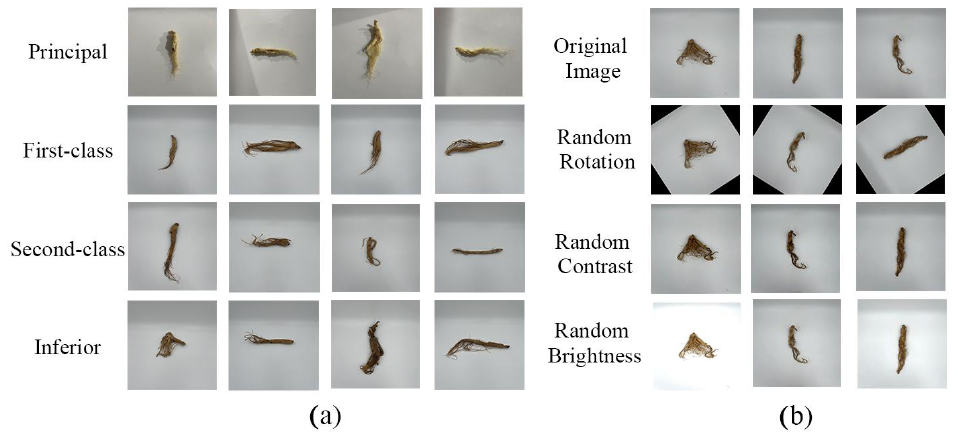
Figure 1. Ginseng (Panax ginseng C. A. Meye) dataset. ( a ) Different levels of ginseng images; ( b ) Image enhancement example diagram.